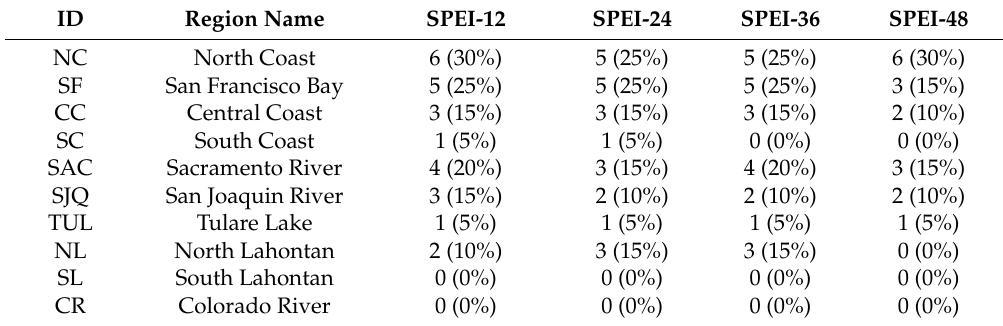
Table 6. Number (percent) of SPEI projections with insignificant trend 1 in the projection